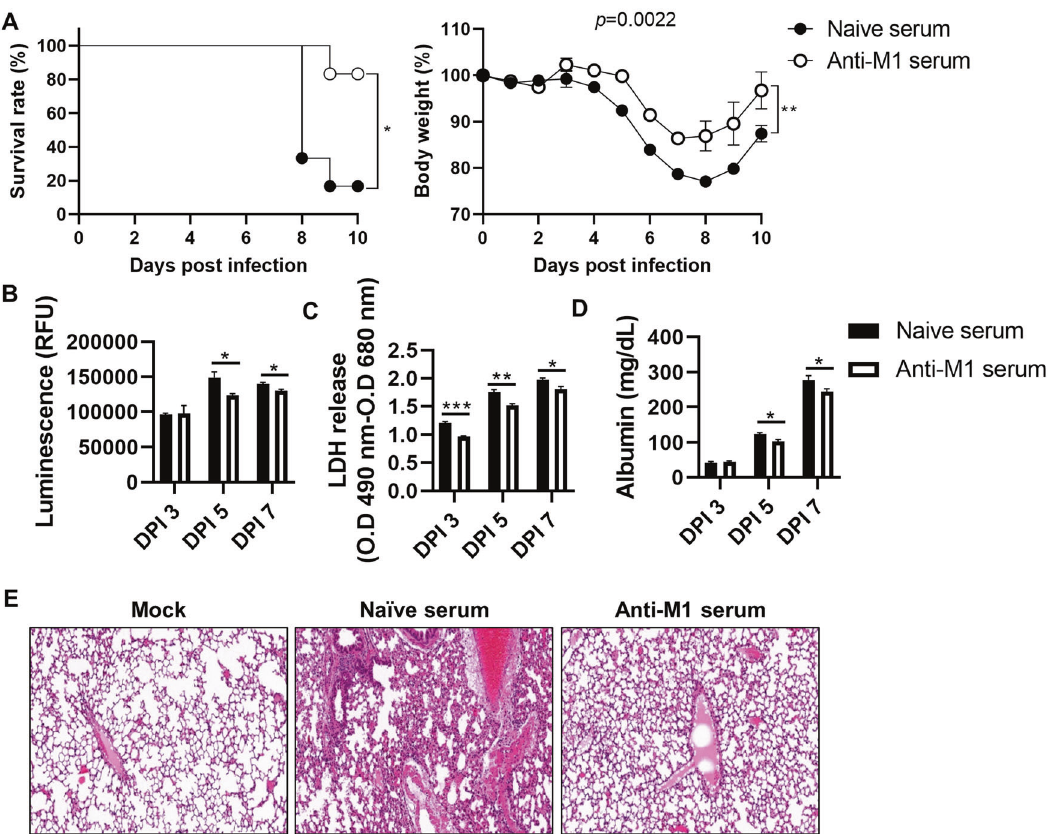
Fig. 7 Anti-M1 serum alleviates in fl uenza viral pathogenicity. Mice infected with PR8 in fl uenza virus (32 PFU) were treated with naïve or anti-M1 serum (200 μ l) once daily for 3 days. A Survival rates and bodyweights of the mice were monitored for 10 days ( n = 8 ). B – D BAL fl uid was extracted on days 3, 5, and 7 post infection and used to analyze levels of ( B ) ROS, ( C ) LDH, ( D ) and albumin. E Lung tissues obtained on day 5 were visualized using H&E staining ( n = 2 ). Data in ( A ) are presented as log-rank tests. Data in ( B – D ) are presented as mean ± SEM. *** p < 0.001, ** p < 0.01, * p <